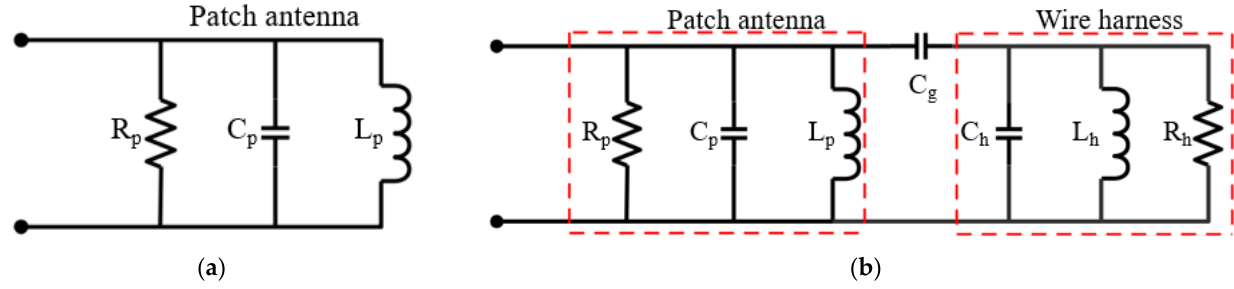
Figure 2. Equivalent circuit model. ( a ) Patch antenna. ( b ) Wire located above patch antenna.